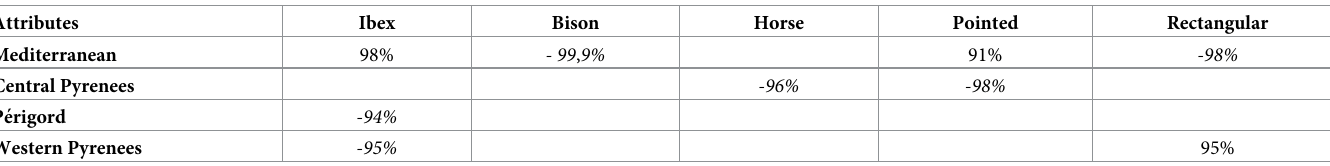
Table 4. Z-test. Probability that the co-occurrence of two attributes is not due to the fluctuations of sampling. Positive values = excess with respect to a random distribu- tion; negative values = default with respect to a random distribution. The percentages indicate the probability that the co-occurrence between the two variables is not due to fluctuations in the